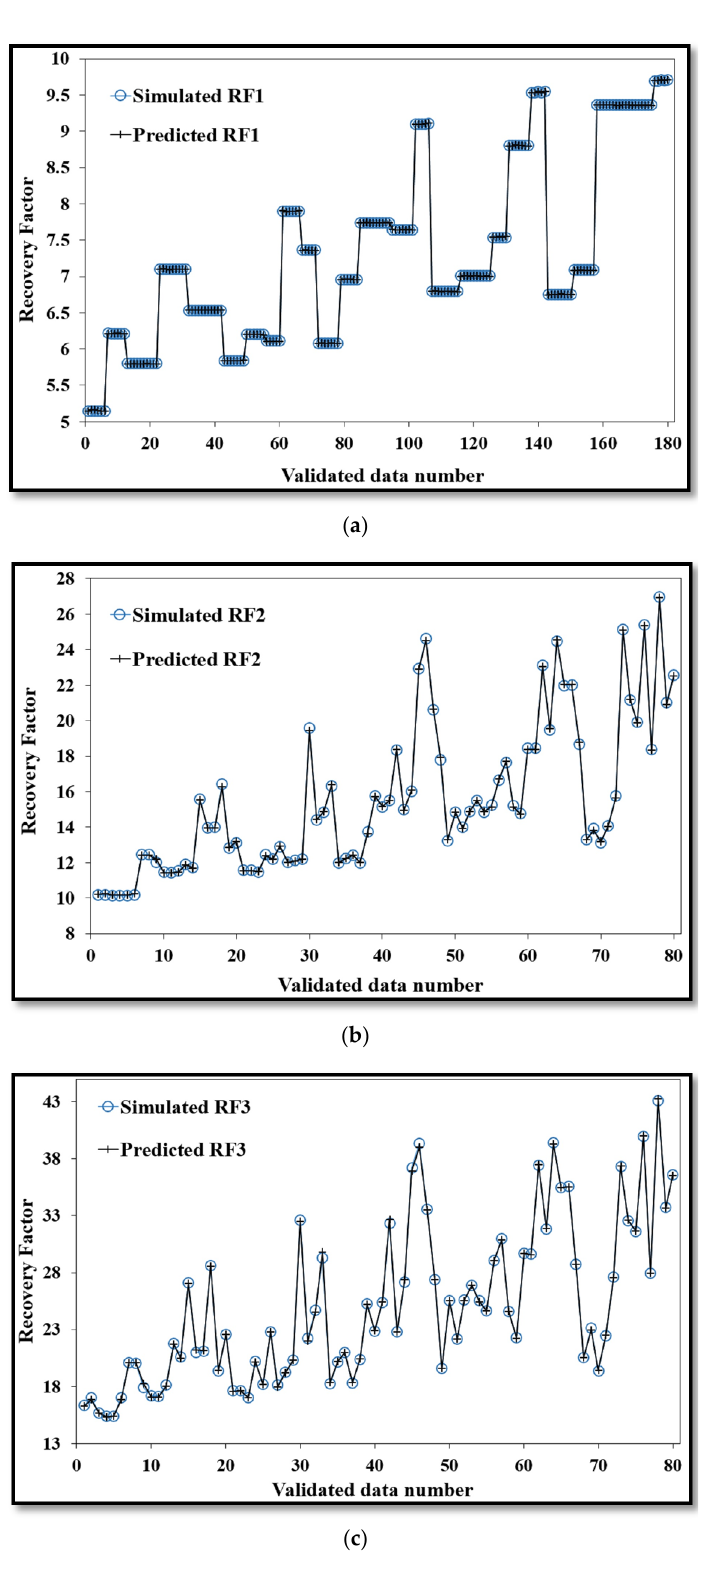
Figure A1. Illustration of the simulated data against the predicted data during the validating process for ( a ) RF 1 , ( b ) RF 2 , and ( c ) RF 3 .